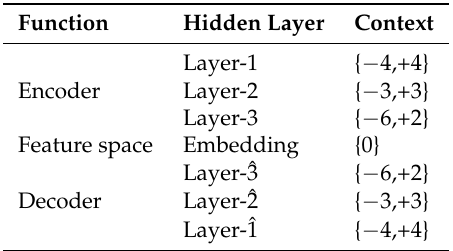
Table 1. The TDNN-based autoencoder structure.